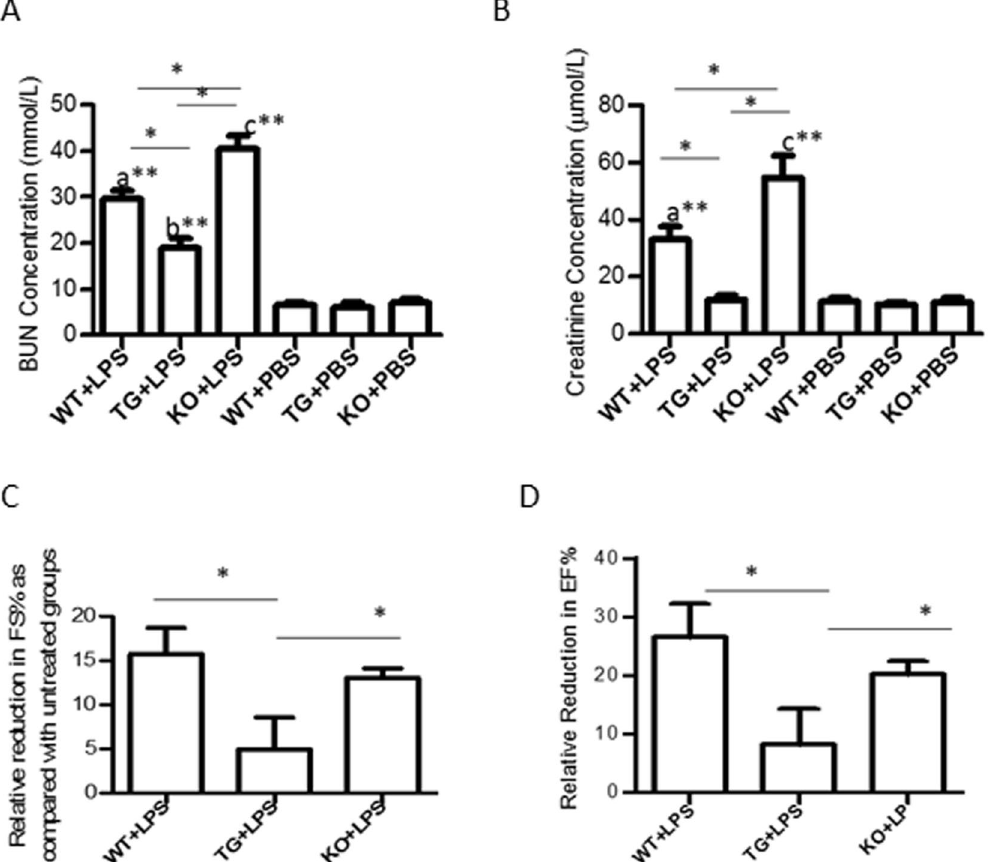
Figure 1. GDF15 deficiency exacerbates cardiac and renal injury after LPS administration. WT, GDF15 TG and GDF15 KO mice were i.p. injected with 4 mg/kg of LPS (WT + LPS, TG + LPS and KO + LPS group) or PBS (WT, TG and KO group) for 16 hours. Blood was collected to measure concentrations of BUN ( A ) and serum creatinine ( B ) to assess renal function Ultrasound scanning was performed to measure EF% ( C ) and FS% ( D ) for heart function. After ultrasound scanning, mice were sacrificed. n = 9–10 for mice treated with LPS and n = 4/group for PBS injected groups in Fig. 1(A,B); n = 5 for ( C , D ); * P ≤ 0.05, ** P ≤ 0.01. a: WT + LPS vs. either WT, TG or KO group; b: TG + LPS vs. either WT, TG or KO group; c: KO + LPS vs. either WT, TG or KO